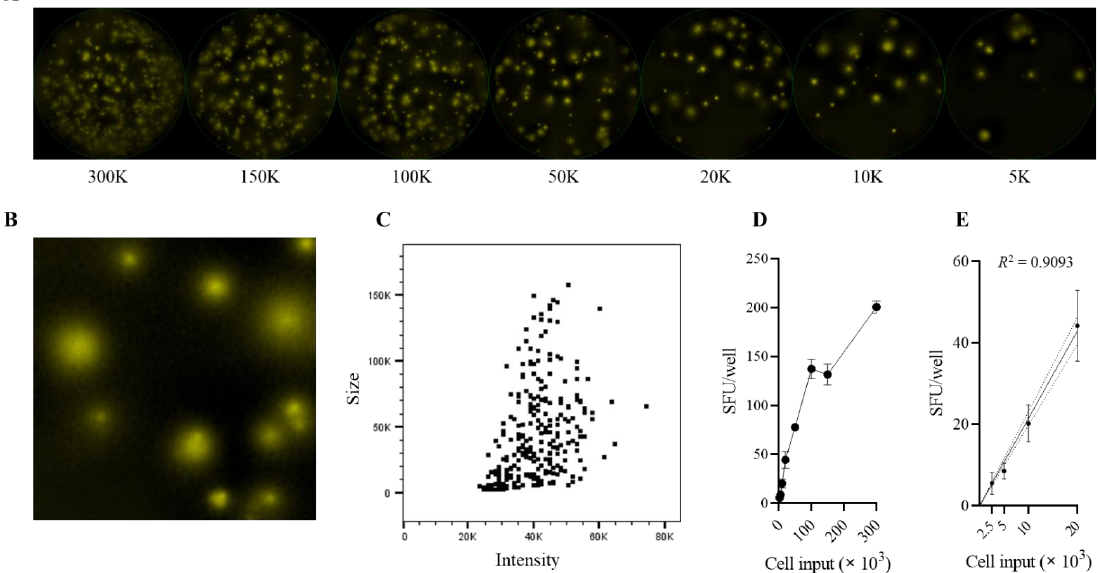
Figure 1. Accurate measurement of SARS-CoV-2 spike (S1)-reactive ASC frequencies. PBMCs from COVID-19 Donor 1 were pre-stimulated for 5 days in vitro to transition resting B cells, irrespective of their specificity, to antibody-secreting cells (ASCs). PBMCs were then seeded into SARS-CoV-2 S1-coated wells with decreasing cell inputs, starting at 3 × 10 5 PBMC/well, with increasing numbers of replicate wells. During the overnight culture period, antibodies originating from S1-reactive ASCs were captured on the antigen-coated membrane in close proximity, and the resulting antibody secretory footprints, or spot-forming units (SFUs), were then detected as described in Materials and Methods. ( A ) Representative well images are shown for the specified cell numbers plated per well (an overview image depicting all replicate wells for COVID-19 Donor 1 is shown in Figure S2). ( B ) Magnification of a representative well image seeded with 2 × 10 4 PBMC/well in which individual SFUs are clearly discernable and exhibit variable sizes and fluorescent intensities. ( C ) SARS-CoV-2 S1-reactive secretory footprints, originating from replicate wells seeded with 2 × 10 4 PBMCs, were merged into a flow cytometry standard (FCS) file and visualized as a bivariate plot depicting the fluorescence intensity (x-axis) and size (y-axis) of the individual FluoroSpots. ( D ) Mean ± SD of SARS-CoV-2 S1-reactive SFU counts as a function of cell input. Note the deviation in linearity for SFU counts originating from wells seeded with greater than 2 × 10 4 PBMC/well inputs. ( E ) Linearity of SARS-CoV-2 S1-reactive SFU counts originating from wells seeded with less